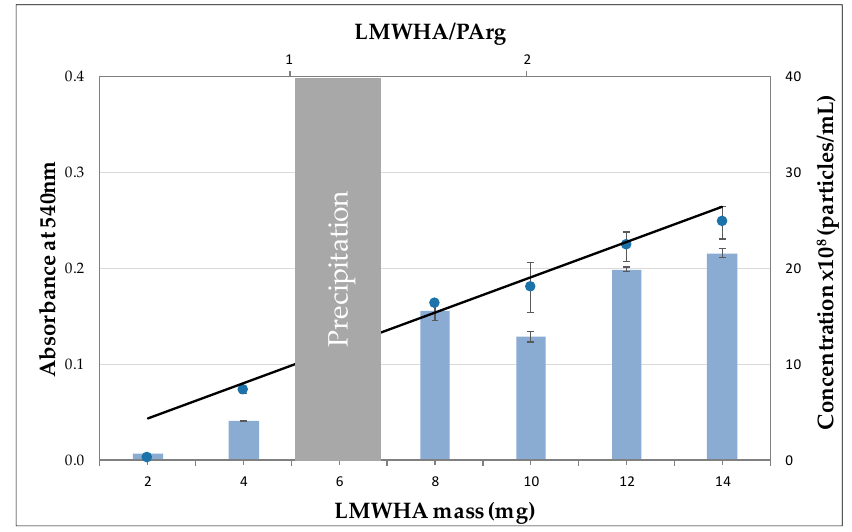
Figure 1. Turbidity (dots) and nanoparticle concentration (bars) as a function of the LMWHA mass and ratio of the components (LMWHA/PArg) (mean ± SD, n = 3).